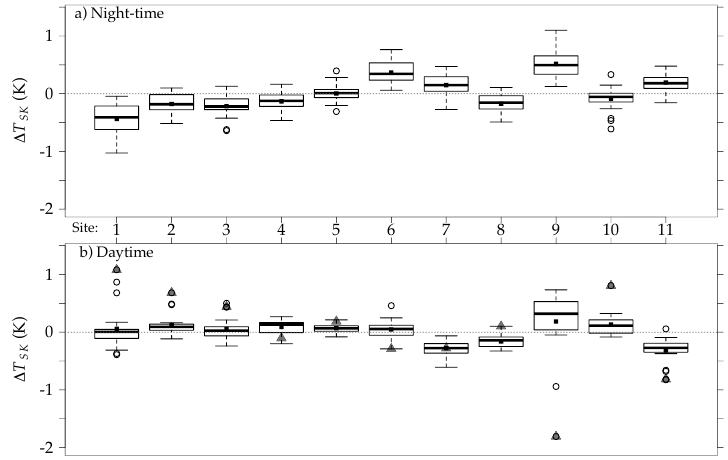
Figure 3. Air temperature ( T ) difference in the study area Schillerkiez at the different measurement sites, depicted as the deviation ( ∆ T SK ) from the spatial mean T for 22 nights and 22 days. Grey triangles mark the values during the clear, calm and dry day (24 June 2016). The bold black line in each box shows the temporal median, the black square the arithmetic mean ( ∆ T SK ). Boxes include data points that are between the 1st and the 3rd quartile (interquartile range IQR). The whiskers show the remaining data points, maximum length is 1.5 times the IQR below the 1st and above the 3rd quartile. Data points outside of this are depicted as